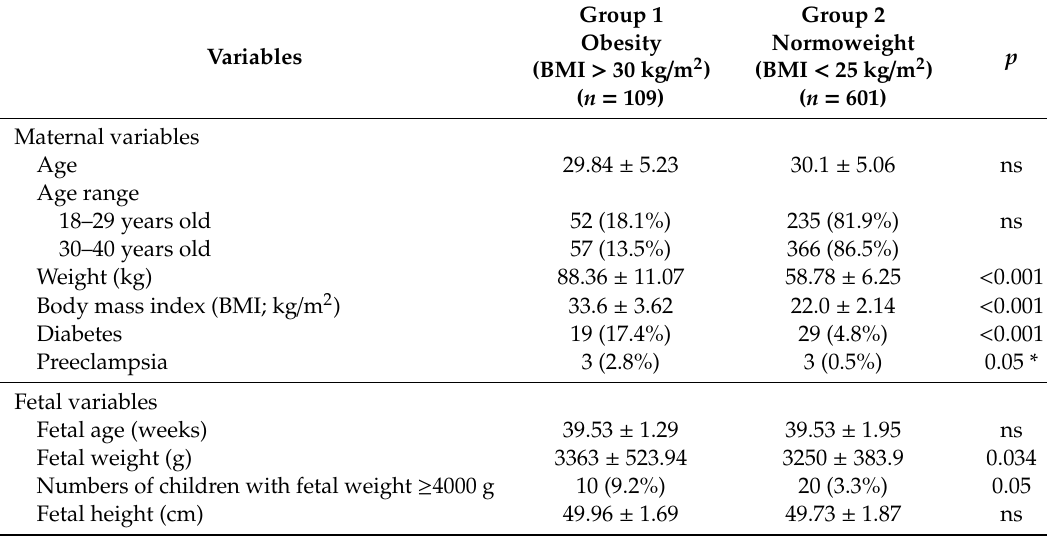
Table 1. Maternal and fetal variables in the normoweight and obesity